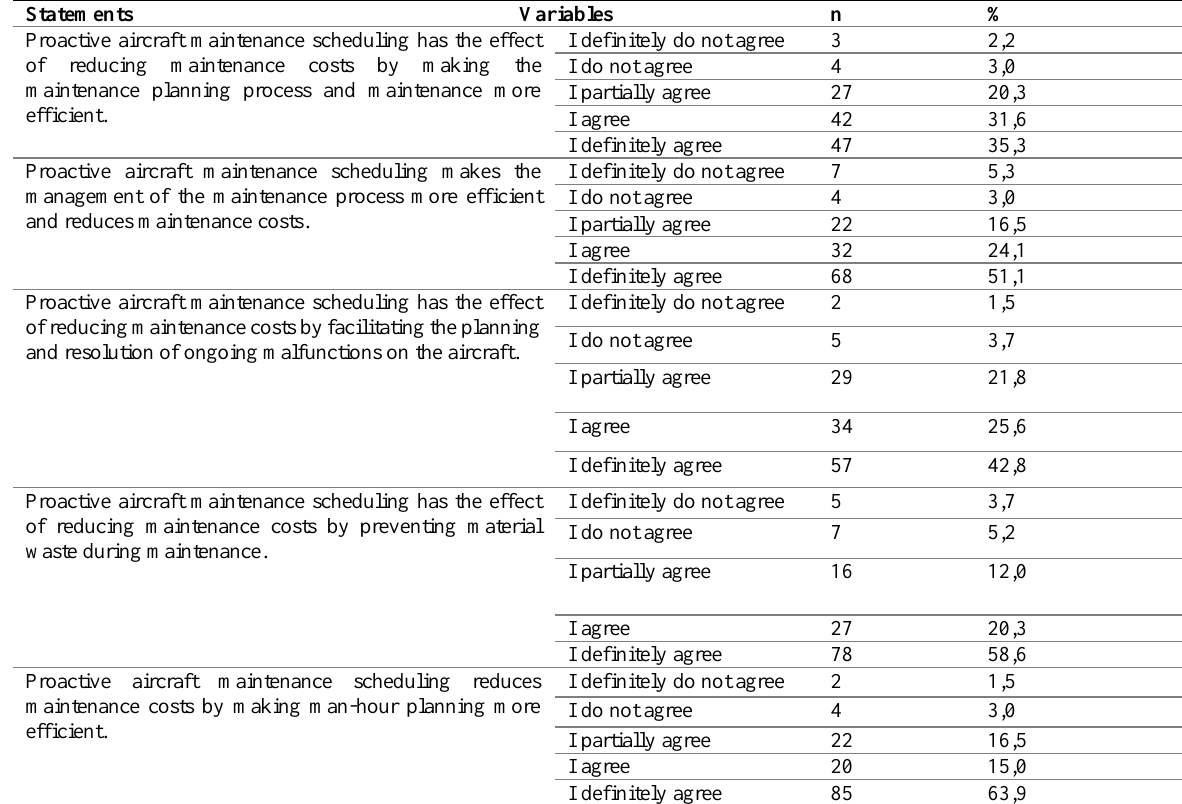
Table 5: Analysis of Data That Contains the Opinion of Turkish Airlines Technic Staff on the Effect of Proactive Maintenance Scheduling on Maintenance Costs and Airline